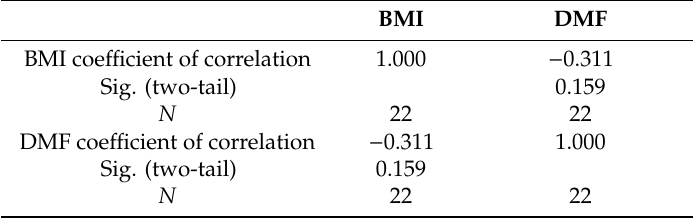
Table 16. Data related to the correlation between BMI and DMF in patients a ff ected by openbite.